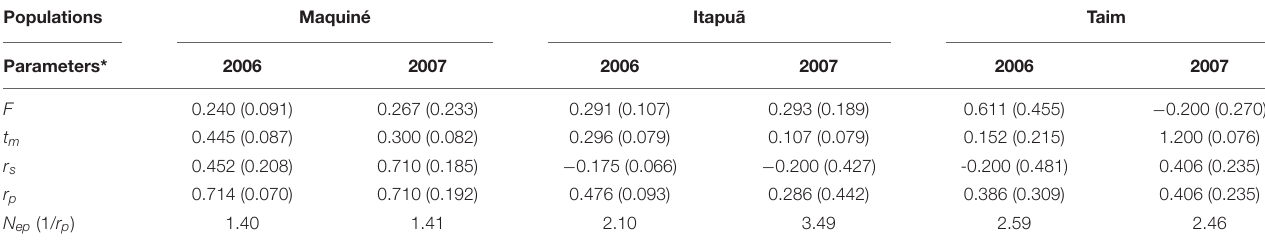
TABLE 4 | Mating system parameters (SD—standard deviation in parentheses) of Vriesea gigantea populations and years.